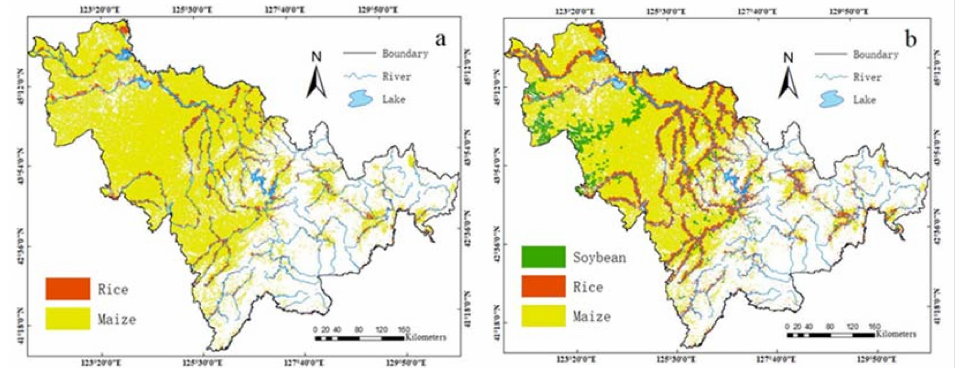
Figure 9. The planting structure optimization map of Jilin province: ( a ) Planting Structure 1; ( b ) Plant- ing Structure